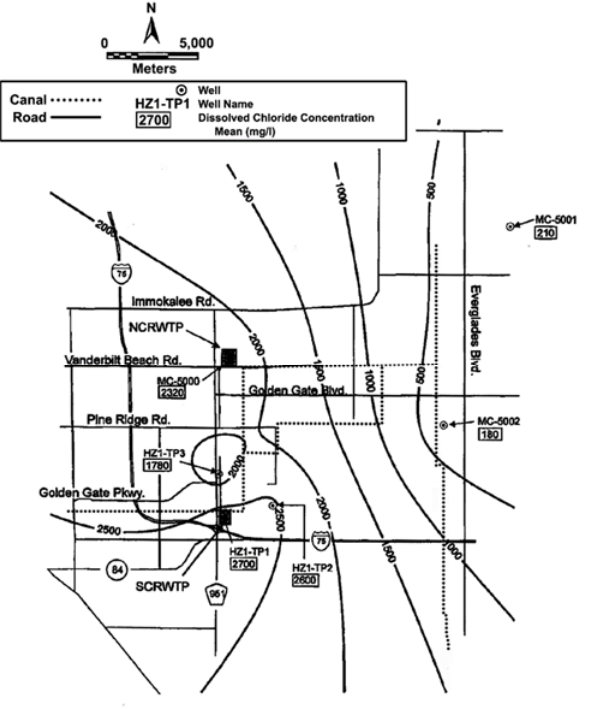
Figure 8. Dissolved chloride concentration distribution in Hawthorn Aquifer System Zone 1 [32].